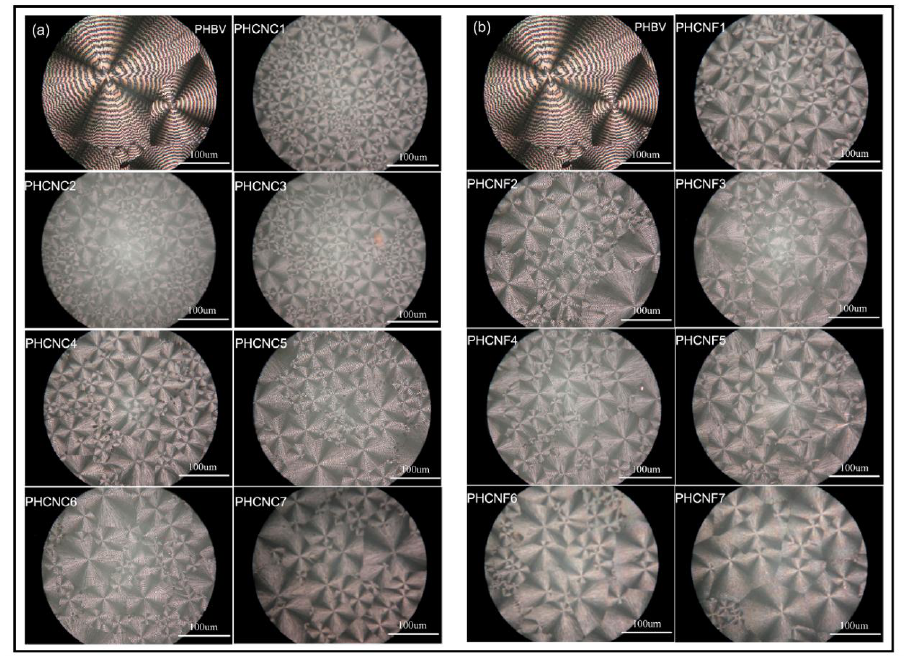
Figure 3. Polarised optical microscope photographs: ( a ) cellulose nanocrystal (CNC)/PHBV composites, and ( b ) cellulose nanofibril (CNF)/PHBV composites. Scale bar represents 100 µm. Reproduced with permission from Ref. [9] .